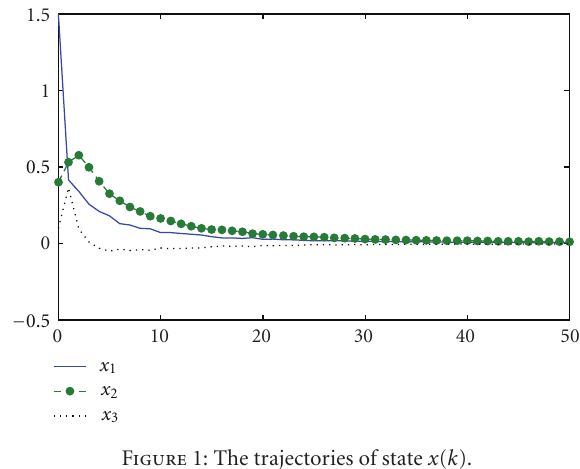
Figure 1: The trajectories of state x ( k ).